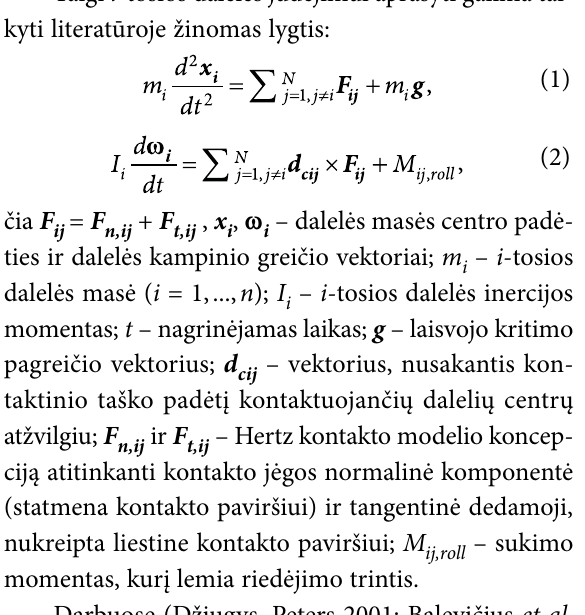
Fig. 1. Stability of the system state: S ( t